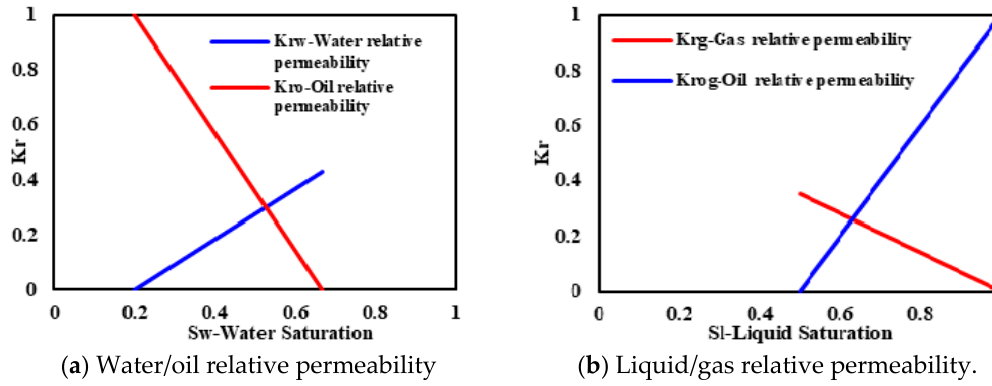
Figure 6. Relative permeability curve of the matrix.